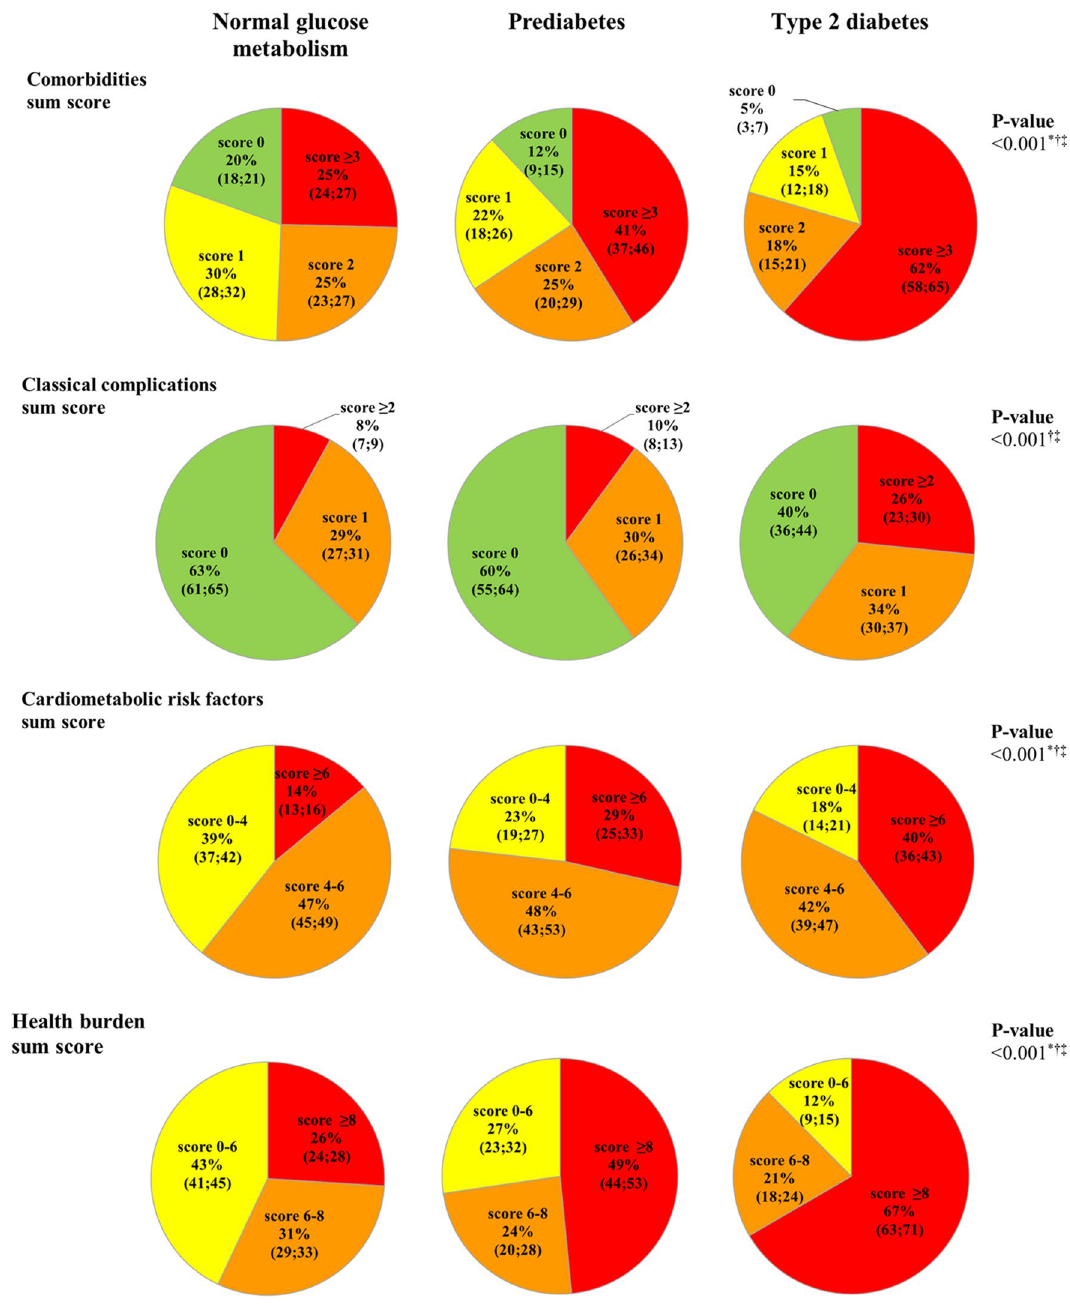
Figure 1. Age- and sex-adjusted sum scores of comorbidities, classical complications, cardiometabolic risk factors, and health burden according to glucose metabolism status. The health burden sum score (0–33) is the total of the number of comorbidities (0–17), classical complications (0–6), and cardiometabolic risk factors (0–10). The numeric categories of the comorbidities, classical complications, cardiometabolic risk factors and health burden sum scores are presented as age- and sex-adjusted frequencies (percentages with their 95% confidence intervals ; with normal glucose metabolism as reference category). Normal glucose metabolism (N = 1,924), prediabetes (N = 511), type 2 diabetes (N = 975). Age- and sex-adjusted linear trend and differences in categories of sum scores among groups of glucose metabolism status were tested with multinomial logistic regression analyses with normal glucose metabolism or prediabetes and the lowest sum score category as reference group. P-linear represents the trend with deteriorating glucose metabolism status for the highest sum score category, and *, †, ‡ represent the differences between groups of glucose metabolism status per highest sum score category. *Prediabetes versus normal glucose metabolism P < 0.001; † type 2 diabetes versus normal glucose metabolism P < 0.001; ‡ type 2 diabetes versus prediabetes P < 0.005. Other P -values > 0.05. Five individuals with normal glucose metabolism had a cardiometabolic risk factors sum score of zero. No individual had a health burden sum score of